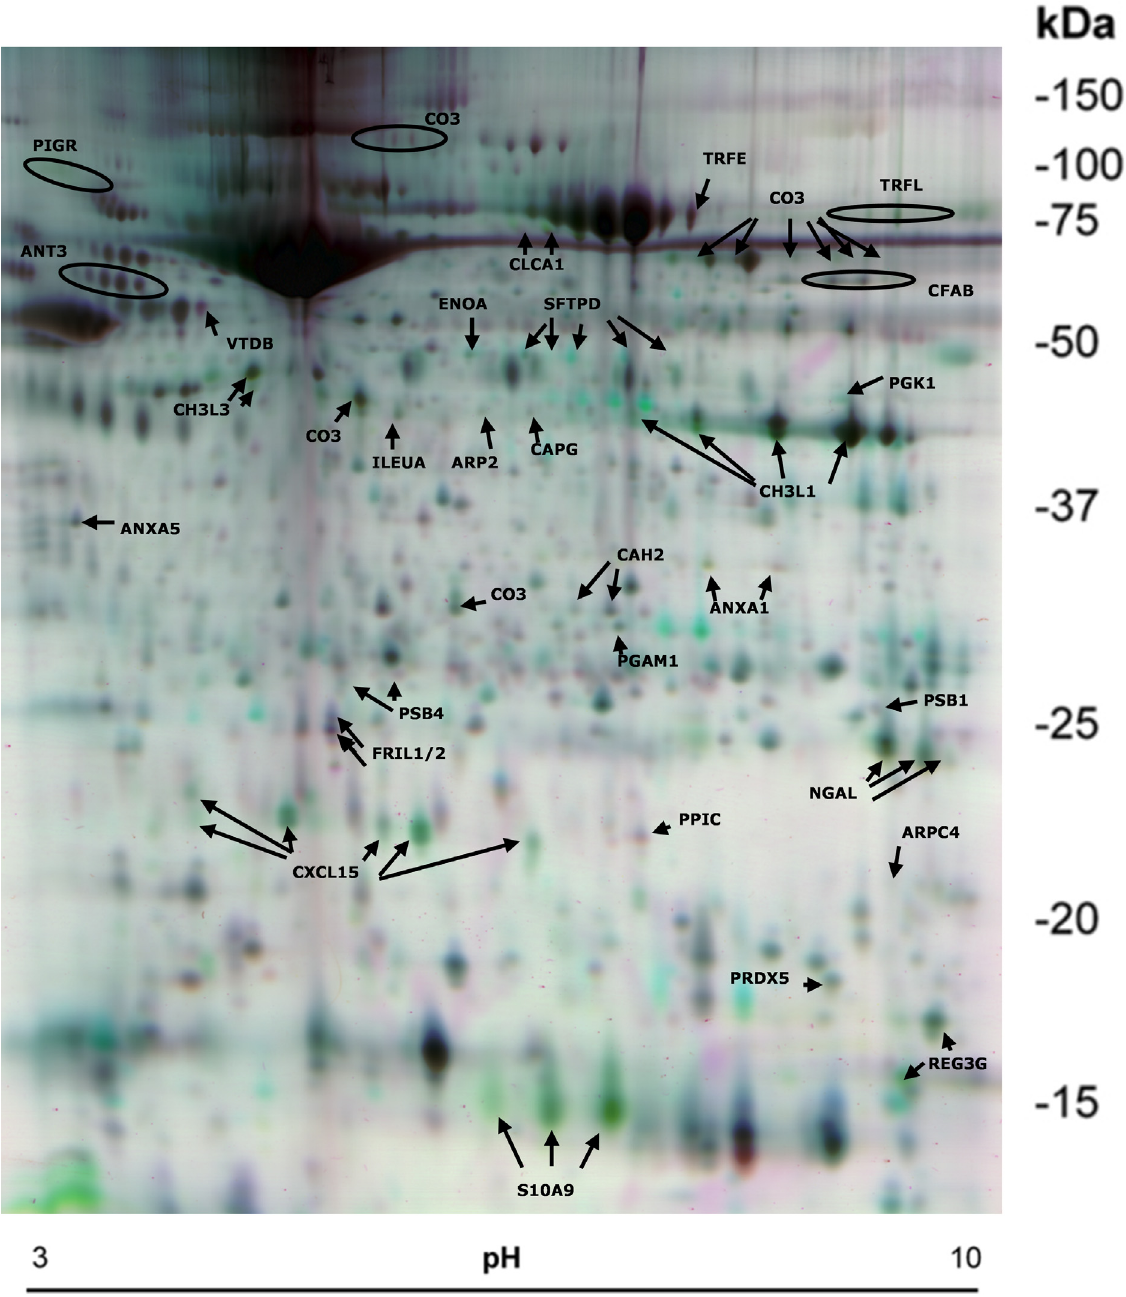
Fig 3. False color 2D-DIGE image of BALF protein spots. WT BALB/c, CD1d -/- and J α 18 -/- mice were exposed to α -GalCer or to a vehicle and their BALFs were used for 2D-DIGE. In the shown gel pair, purple spots represent decreased abundance and green spots represent increased protein abundance in the α -GalCer — treated WT samples as compared to vehicle-treated WT samples. Protein spots identified with LC-MS/MS are labelled with their UniProt entry name and are listed in Table 1.